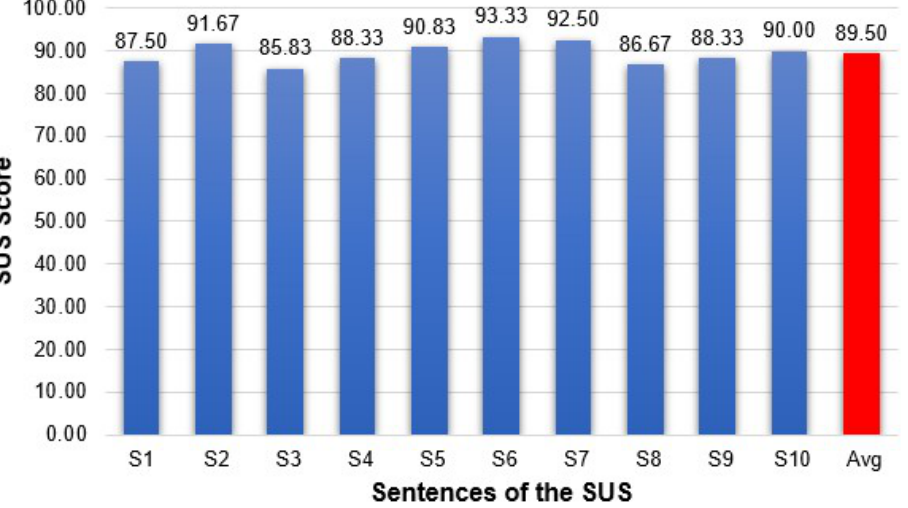
Figure 17. System Usability Scale (SUS) score of each item of the questionnaire.